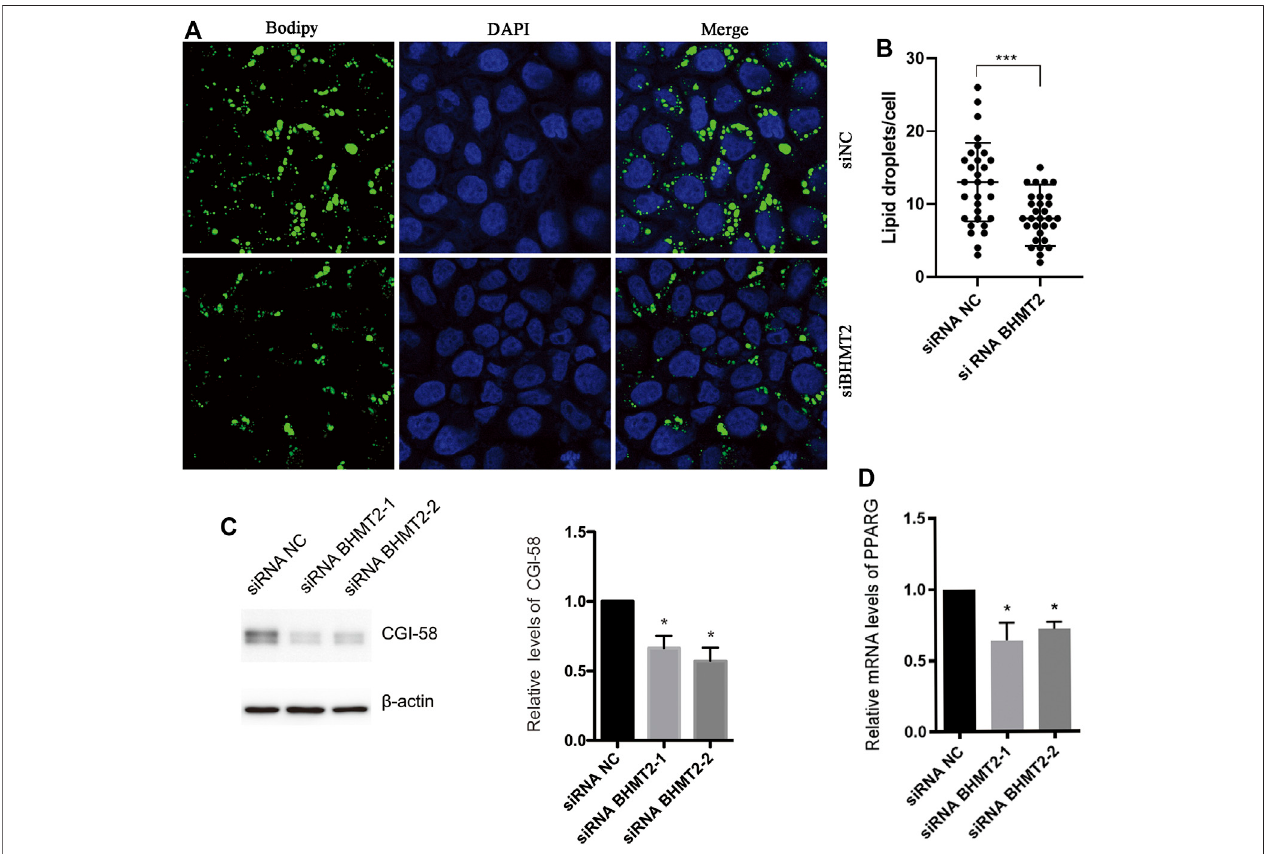
FIGURE 7 | BHMT2 may be involved in hepatocyte lipid metabolism by regulating the expression of PPAR in vitro . (A) L02 cells were transfected with BHMT2 siRNA and controlsiRNA. (B) The number oflipid droplets per cellshown in (A) wasquanti fi ed. (C) Westernblottingresults ofCGI-58, β -actin isasaloadingcontrol. (D) PCR results of PPARG. (* p < 0.05; ** p < 0.01; *** p < 0.001).